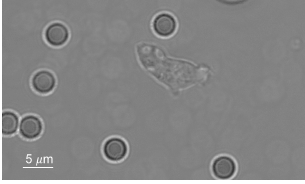
Figure 3. Smudge free image of amoeba cell and silica beads in water.